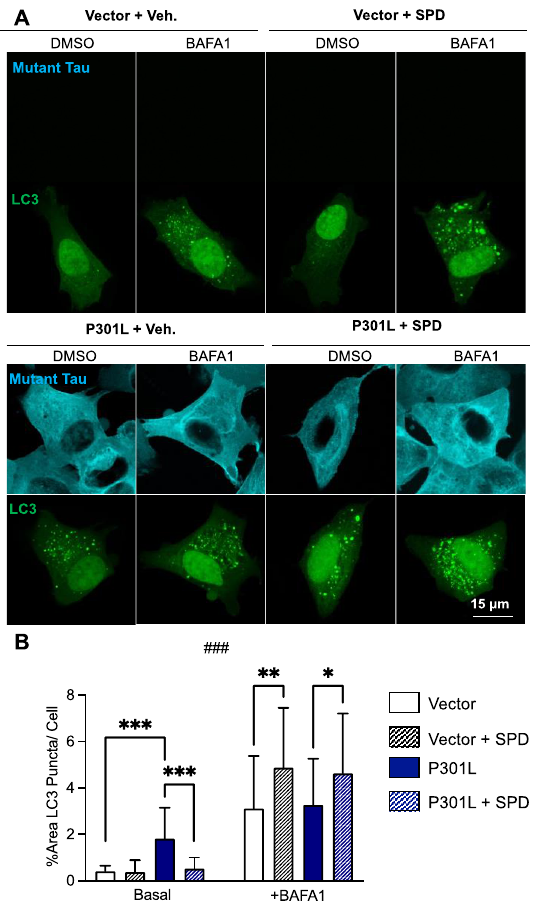
Figure 4. Effects of spermidine on autophagy in P301L tau-expressing cells and vector cells. ( A ) Autophagic flux was assessed in vector and P301L cells by stimulating them with the autophagosome–lysosome fusion inhibitor Bafilomycin A1 (BAFA1, 100 nM) or DMSO alone. LC3 puncta (green), indicators of autophagosome formation, were then quantified. ( B ) P301L tau-expressing cells exhibit increased LC3 puncta levels when compared with vector cells at baseline. Spermidine